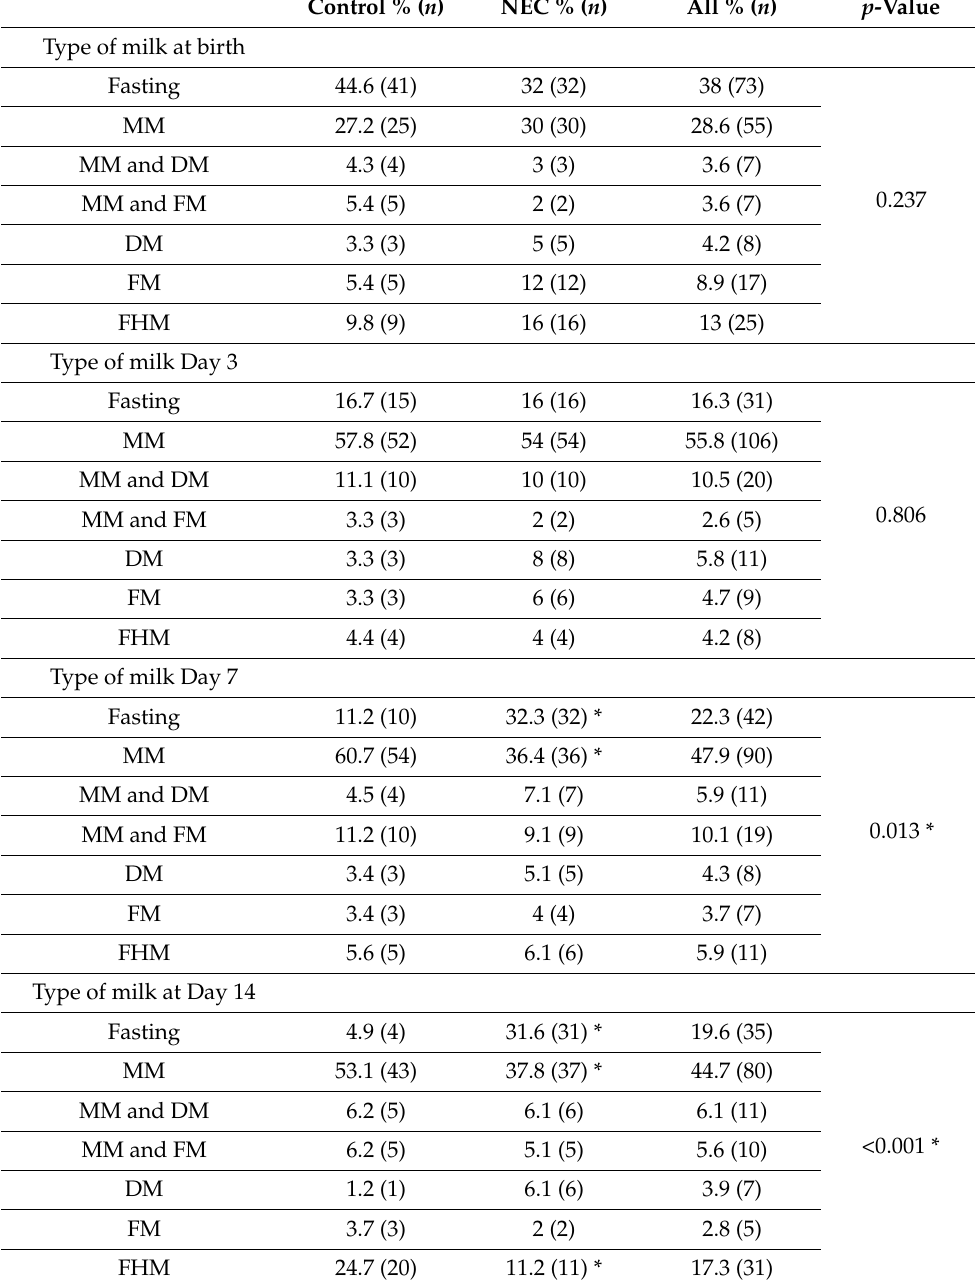
Table 3. Transversal feeding results for Control and NEC